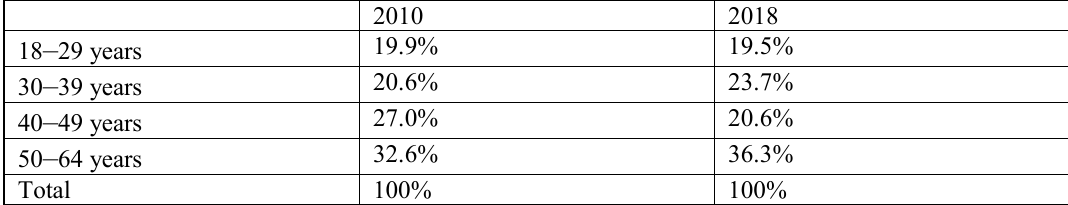
Table 4: Proportions of different age groups among the low literate population